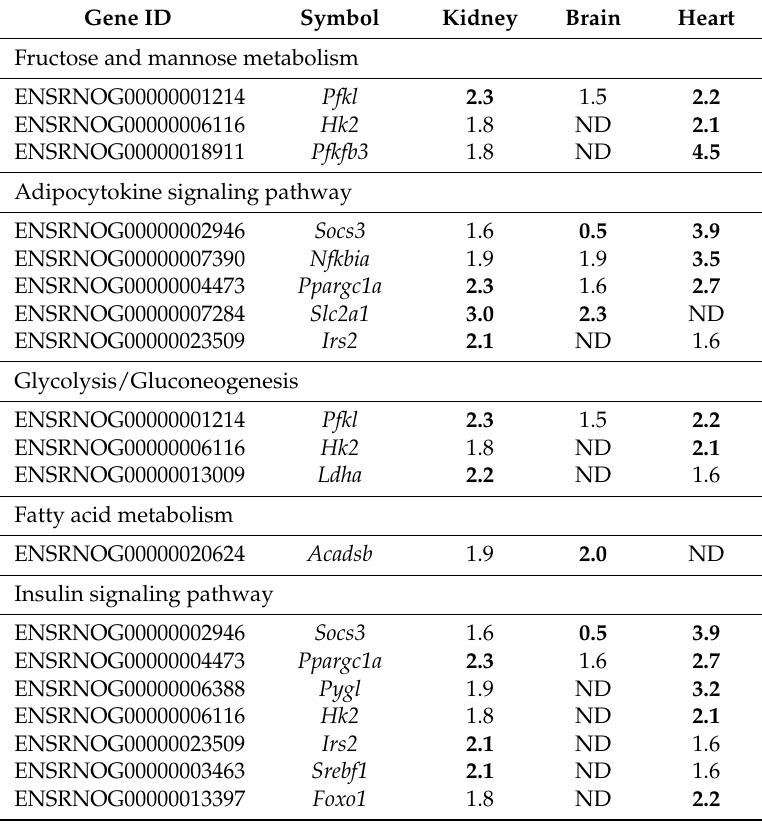
Table 2. Changes in the expression of shared differential expressed genes (DEGs) associated with fructose metabolism in the kidneys, brain, and heart of offspring exposed to maternal HF diet at 1 day of